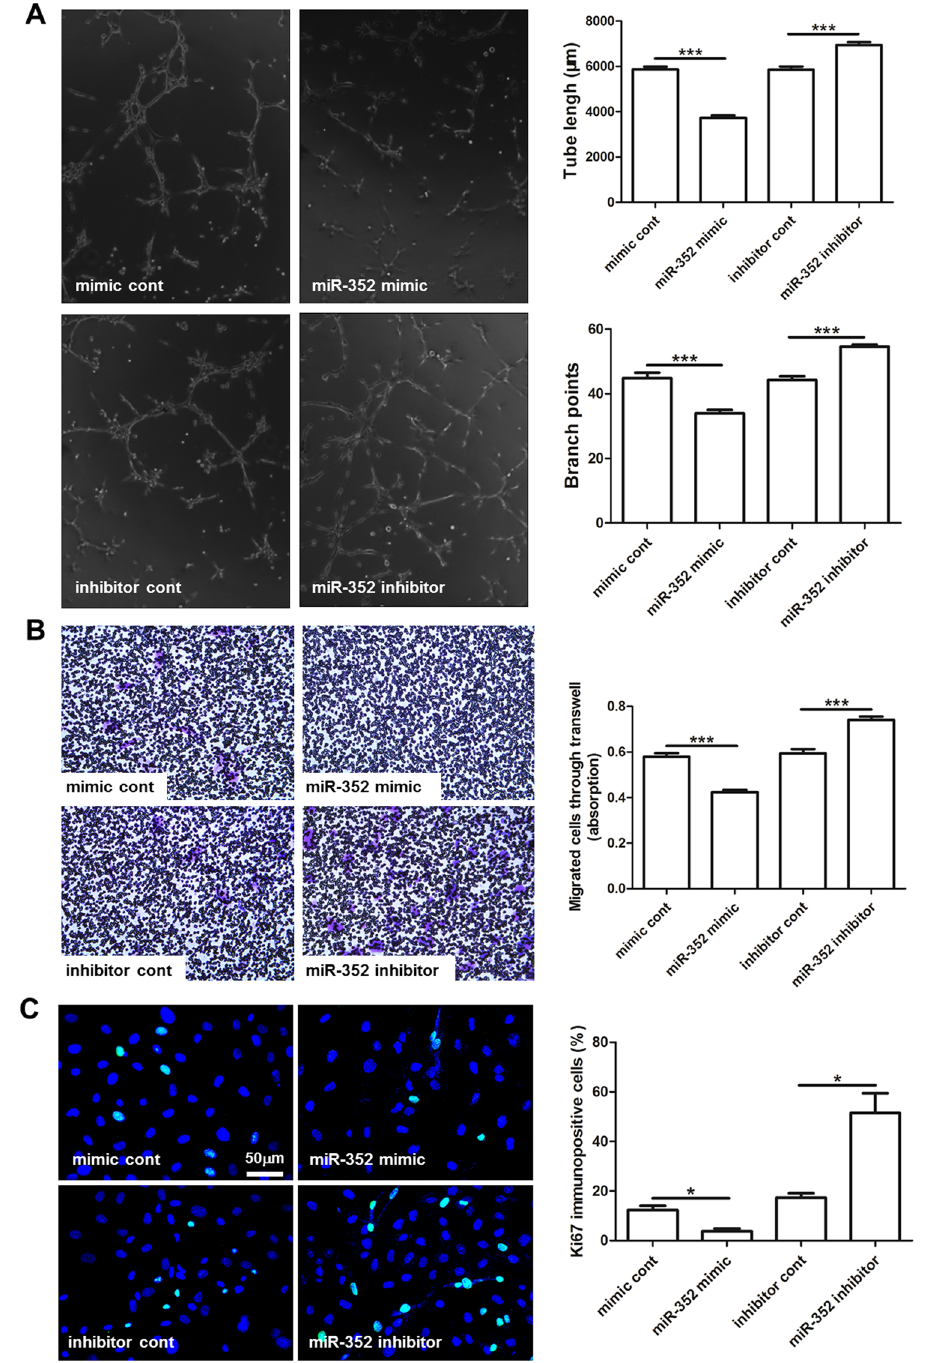
Figure 2. Effect of miR-352 overexpression or inhibition on angiogenesis in cultured rat aorta endothelial cells (RAECs). RAECs were transfected with either miR-352 mimic, miR-352 inhibitor or the respective negative controls: mimic control/inhibitor control. ( A ) Transfected cells were cultured on Matrigel, and the cumulative sprout length and branch points of capillary-like structures were measured after 6 hours. miR-352 mimic attenuated angiogenic tube formation, whereas inhibition of miR-352 had a stimulatory effect. ( *** P < 0.001, n = 3). ( B ) Stained migratied transfected cells on the bottom side of the Transwell chamber after 24 hours. miR- 352 mimic attenuated cell migration, whereas inhibition of miR-352 promoted cell migration. ( *** P < 0.001, n = 3). ( C ) Proliferation of transfected cells was examined by Ki67 immunostaining. Green for Ki67, and blue for nuclei. miR-352 mimic attenuated cell proliferation, whereas miR-352 inhibitor promoted cell proliferation ( * P < 0.05, n =